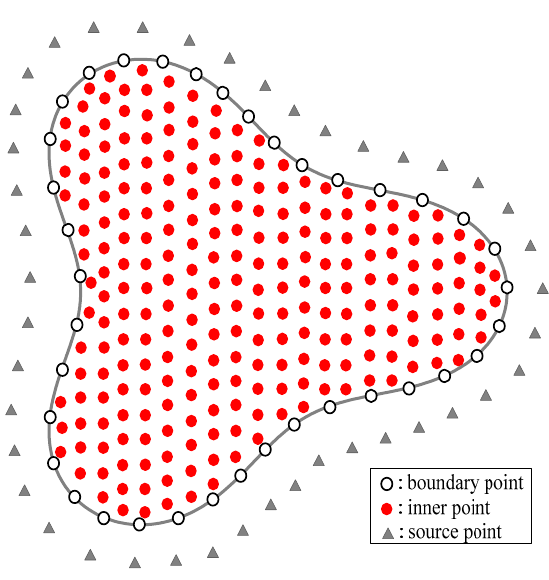
Figure 6. Layout of collocation points.